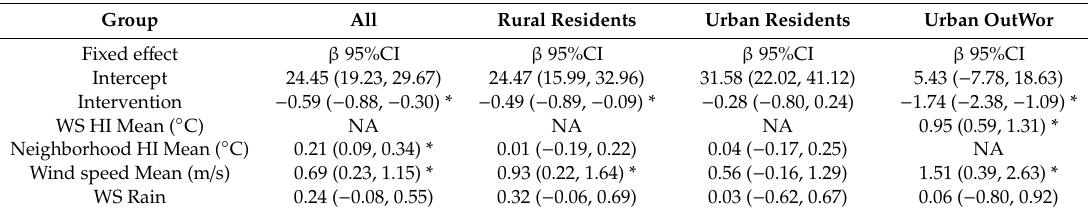
Table 4. Intervention e ff ects on daily maximum heat index ( ◦ C) experienced by individuals in di ff erent population groups. Group All Rural Residents Urban Residents Urban OutWor Fixed e ff ect β 95%CI β 95%CI β 95%CI β 95%CI Intercept 45.13 (33.44, 56.73) 34.91 (8.80, 51.01) 55.64 (34.37, 76.79) − 10.00 ( − 59.85, 39.87) Intervention − 1.40 ( − 2.27, − 0.53) * − 0.24 ( − 1.36, 0.88) − 0.73 ( − 2.32, 0.86) − 6.60 ( − 9.09, − 4.11) * WS HI Max ( ◦ C) NA NA NA 2.03 (0.71, 3.35) * Neighborhood HI Max( ◦ C) 0.15 ( − 0.07, 0.37) 0.07 ( − 0.21, 0.36) − 0.01( − 0.43, 0.41) NA Wind speed Max (m / s) 0.49 (0.21, 0.76) * 0.23 ( − 0.13, 0.59) 1.01 (0.53, 1.49) * 0.30 ( − 0.60, 1.19) WS Rain − 0.05 ( − 0.98, 0.88) 1.01 (0.02, 2.00) * − 2.30 ( − 4.22, − 0.39) * − 3.52 ( − 6.74, − 0.30)